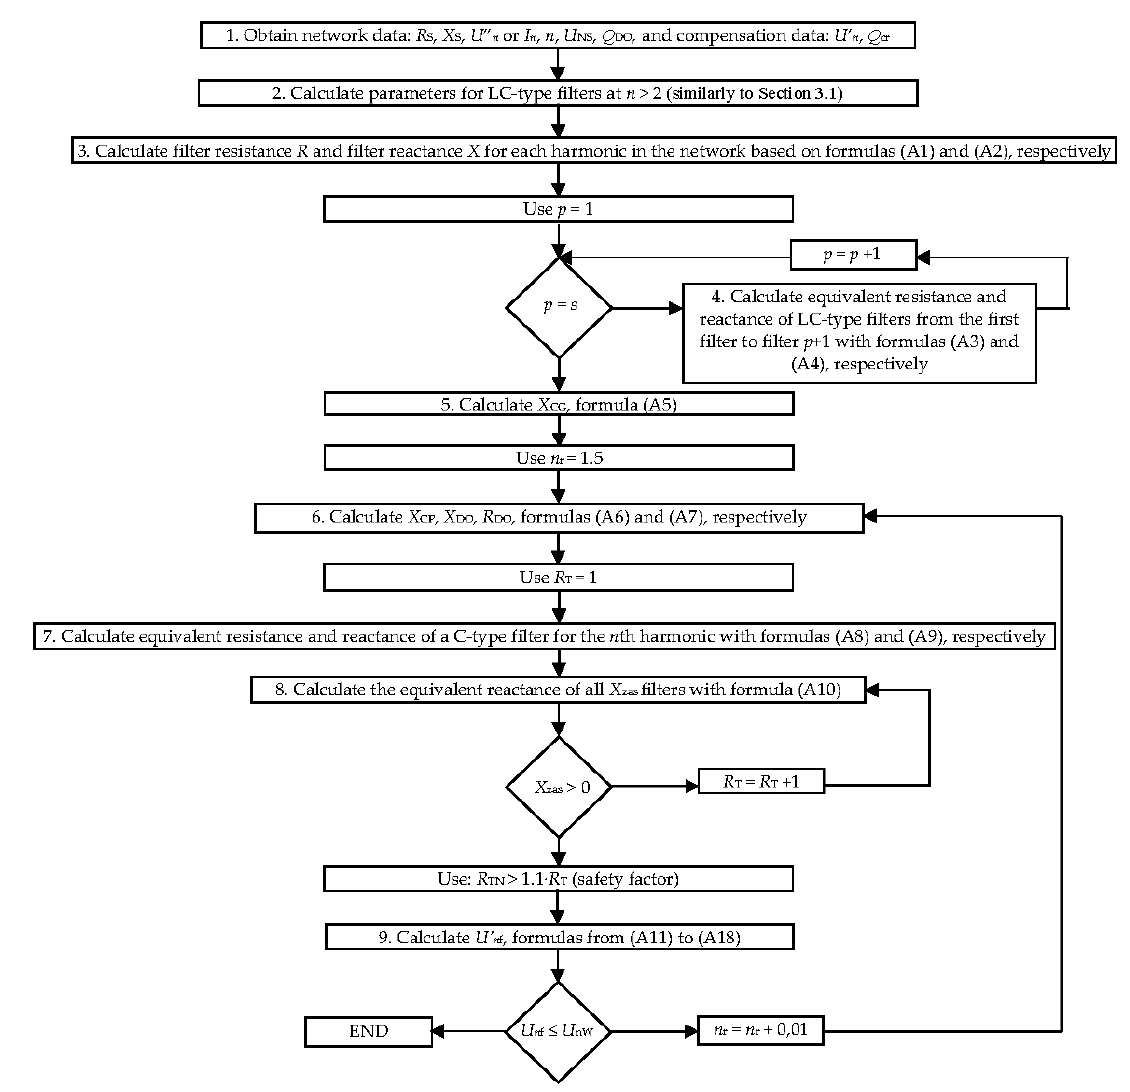
Figure 5. Algorithm steps for calculating the parameters of a C-type filter for the required U n ’ as in Equations (A1) to (A18) Appendix A.